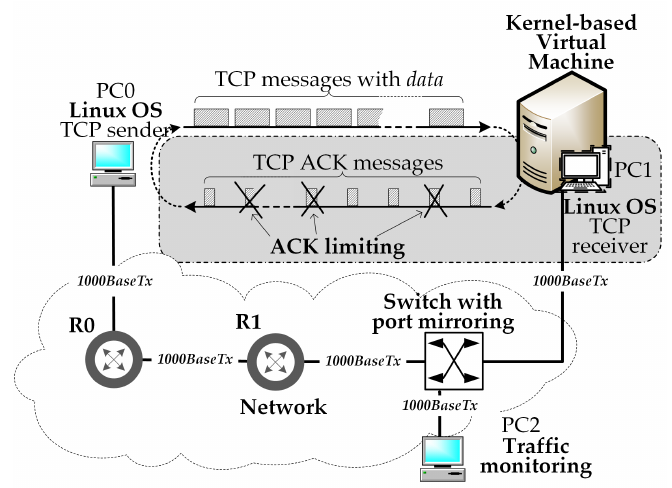
Figure 9. Test setup of the TCP ACK rate limiting on the virtual